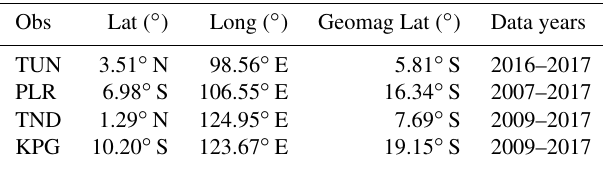
Table 1. Indonesian observatories which are used to derive defini- tive